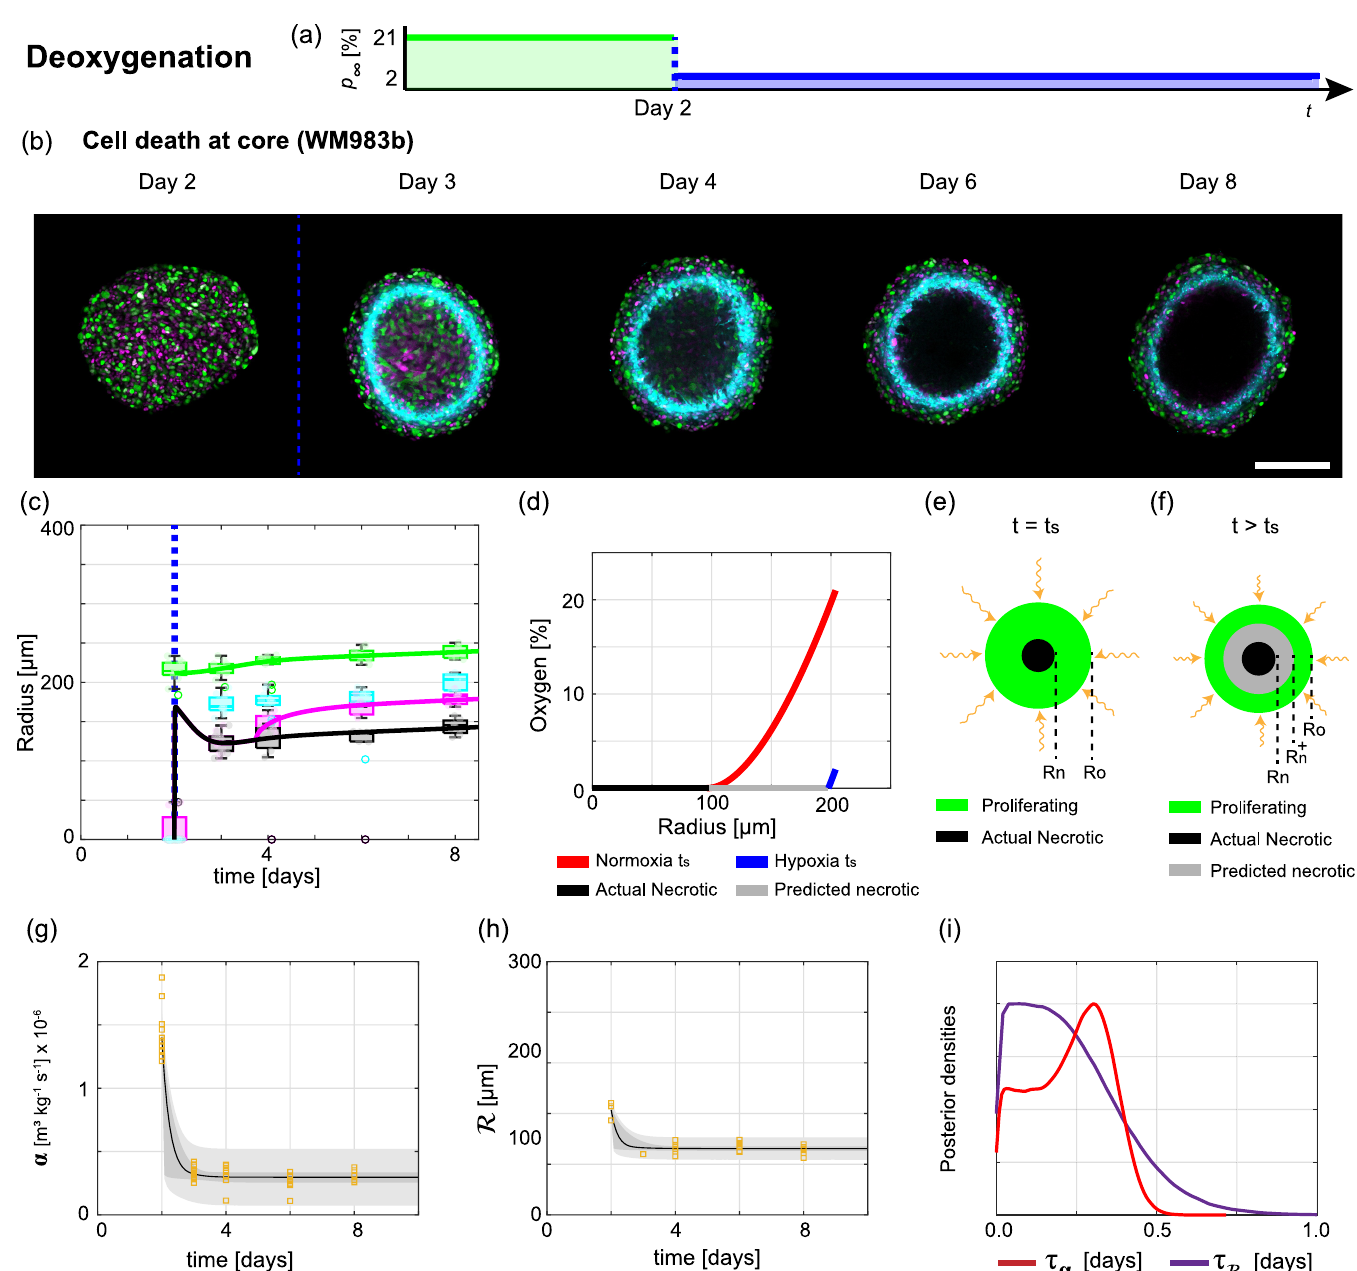
Fig 4. Analysis of deoxygenation experiments reveals tumour spheroid adaptation mechanisms. (a) Schematic for deoxygenation experiment where the external oxygen partial pressure switches from normoxia to hypoxia at t s = 2 [days]. (b) Experimental images of the equatorial plane of WM983b spheroids on Days 2, 3, 4, 6, and 8 after seeding. Scale bar is 200 μ m. Colours in (b) correspond to cell cycle schematic shown in Fig 1D and hypoxic regions are shown by pimonidazole staining (cyan). Necrotic region forms on Day 3 (blurry central region) and grows (dark central region on Days 4, 6, and 8). (c) Comparison of experimental data (box charts) with deoxygenation mathematical model (solid line) simulated with the maximum likelihood estimates of parameters. Time evolution of outer radius R o ( t ) (green), inhibited radius R i ( t ) (magenta), hypoxic radius R p ( t ) (cyan), and necrotic radius R n ( t ) (black). Blue vertical dashed lines in (b-c) indicate t s . (d) Oxygen partial pressure within a spheroid estimated at t s under normoxia (red) and hypoxia (blue). (e-f) Schematics for spheroid structure in: (e) normoxia at t = t s ; and, (f) hypoxia immediately after t s . In (f) the predicted necrotic radius, R þ ð t Þ , is greater than the actual necrotic radius, R n ( t s ), due to the reduced external oxygen partial pressure. Cells in region R þ ð t Þ < s n n ð t Þ die due to lack of oxygen and increase the volume of the necrotic core. (g-i) Analysis of spheroid snapshots in deoxygenation experiment. (g) Estimates of r < R n oxygen consumption rate, α [m 3 kg − 1 s − 1 ], from analysis of spheroid snapshots (orange squares) compared to prediction intervals generated from the deoxygenation mathematical model. (h) Estimates of the outer radius when the inhibited region forms, R ð t Þ [ μ m], from analysis of spheroid snapshots (orange squares) compared to prediction intervals generated from the mathematical model. In (g-h) deoxygenation model simulated with the posterior means of the parameters (black), 50% posterior region of prediction interval (dark grey), and 97.5% posterior region of prediction interval (light grey). (i) Posterior density estimates for the timescales of adaptation of the oxygen consumption rate and outer radius when the inhibited region forms denoted by τ α (purple) and t (red). R